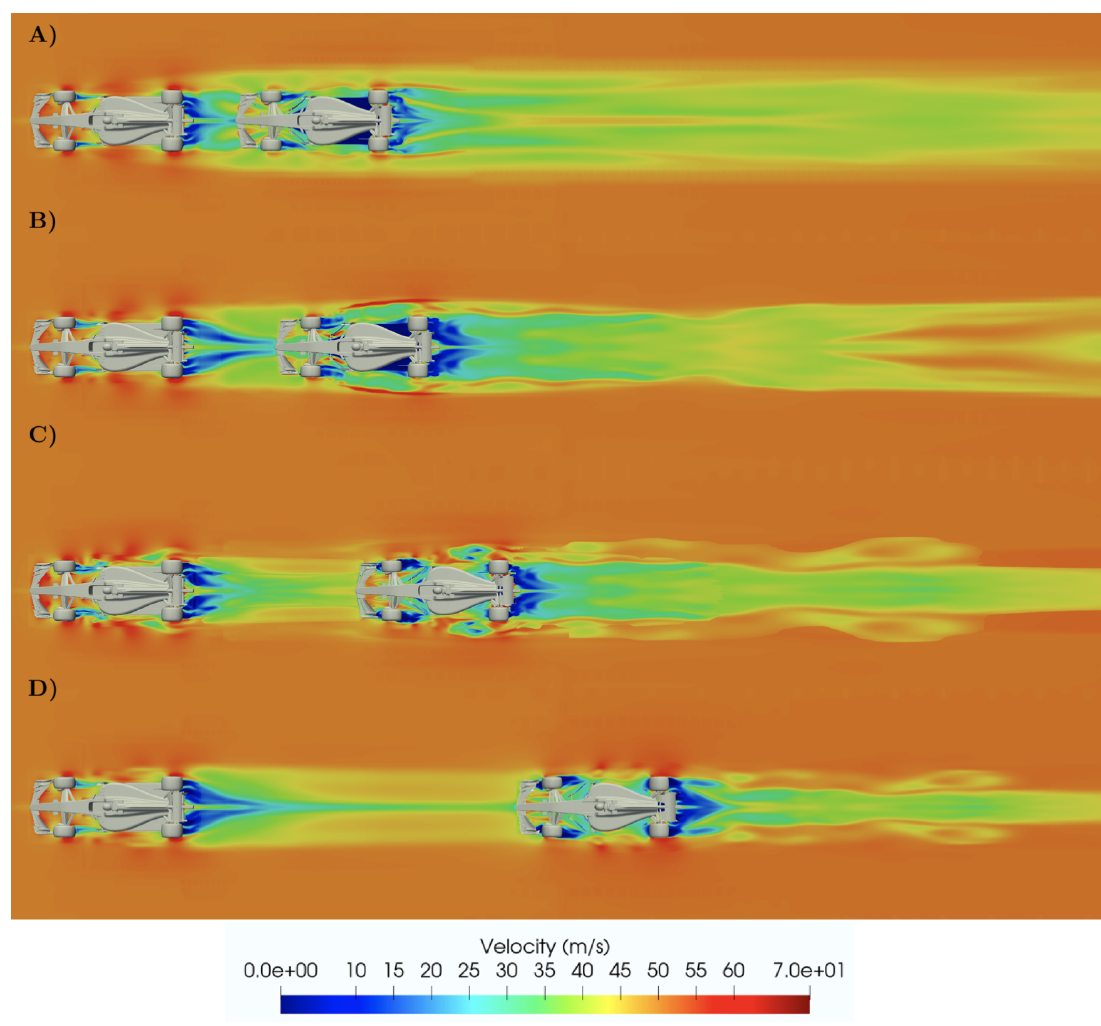
Figure 24. Velocity contours on a top plane at a distance of ( A ) 0.25 L, ( B ) 0.5 L, ( C ) 1 L, and ( D ) 2